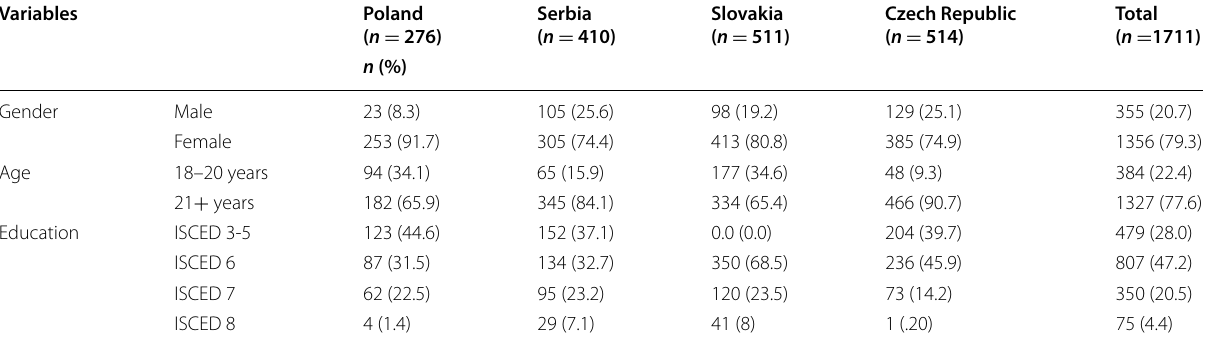
Table 1 Demographic details of the samples